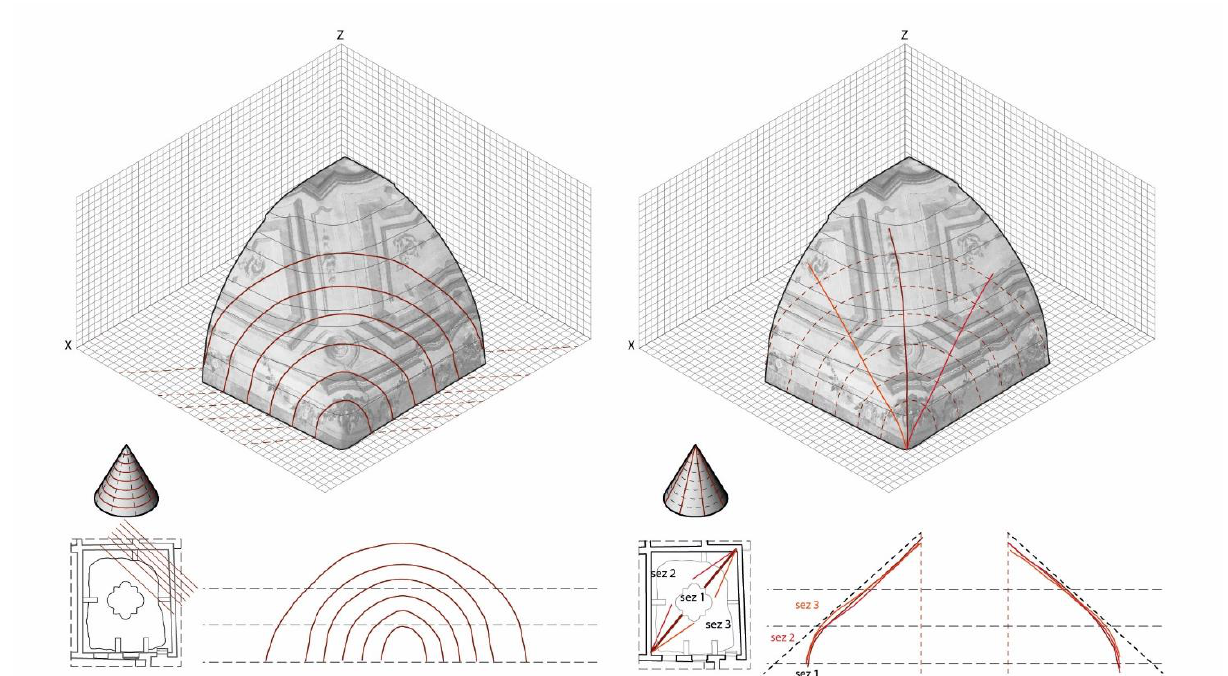
Figure 9. Two different ways of slicing the intrados surface to carry out corner analysis: the first profiles, extracted along bricks arrangement, and the second ones radially to identify the generatrix of a cone. Another way to confirm the initial hypothesis would be to verify the corner geometry using radial sections obtained cutting the point cloud to identify the generative straight line. The results obtained at the extrados, do not show a clear shape. The radial section that bisects an angle identifies a curvilinear profile that only in the central part resembles a straight line (Figure 10).